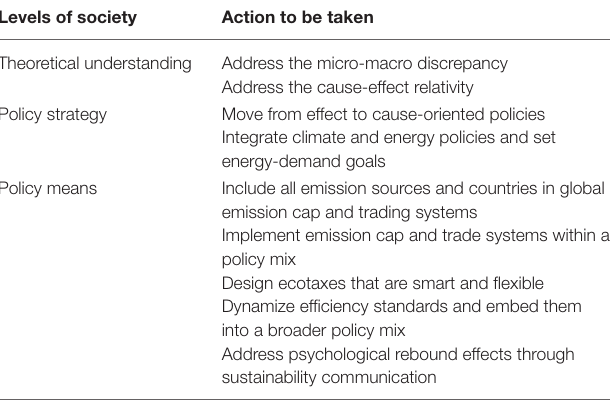
TABLE 1 | Lessons learned for rebound